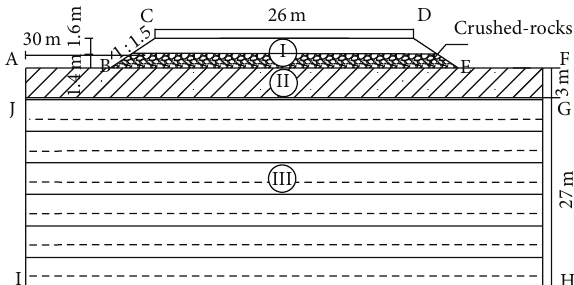
Figure 3: The model of the closed crushed-rocks embankment with the wide road pavement.